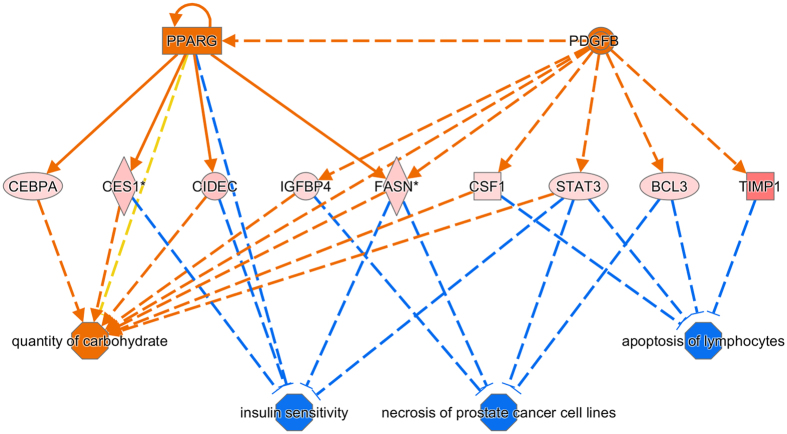
The Regulator Effects tool of the IPA package was employed to identify two major upstream regulators (PPARG and PDGFB) of the networks of differentially expressed genes.This tool integrates Upstream Regulator results with Downstream Effects results to build causal hypotheses that help to interpret what may be occurring upstream to cause particular phenotypic or functional outcomes downstream (http://www.ingenuity.com/products/ipa/ipa-spring-release-2014). In the upper tier, there are two upstream regulators (PPARG and PDGFB) predicted to be activated (orange color). In the middle tier, we can see the genes whose expression changes in response to the activation of upstream regulators (red = upregulation). The shapes of the nodes reflect the functional class of each gene product: enzyme (vertical rhombus), transcription regulator (vertical ellipse), cytokine/growth factor (square), ligand-dependent nuclear receptor (horizontal rectangle) and complex/group/other (circle). In the lower tier, the expected phenotypic consequences of changes in gene expression are shown by considering the Ingenuity Knowledge Base (absolute z-score > 2 and P-value < 0.05). The octagonal symbol defines Function, while solid and dashed lines between genes represent known direct and indirect gene interactions, respectively. Orange leads to activation, while blue leads to inhibition predicted relationships. Orange (predicted to be activated) and blue (predicted to be inhibited) lines represent relationships with causal consistency.